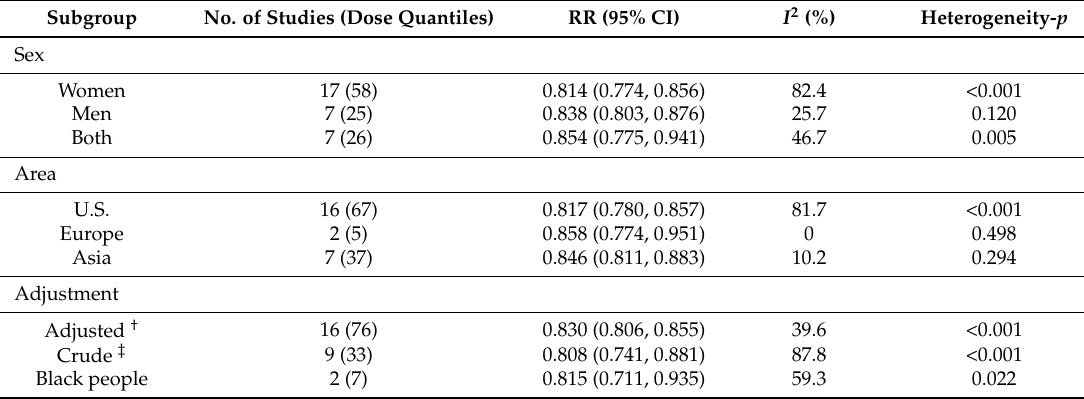
Table 2. Pooled RRs * for T2D incidence of increased dietary magnesium intake by sex, area and